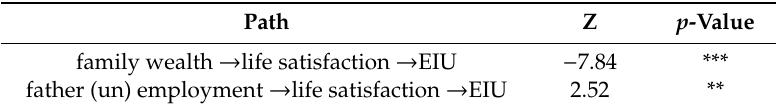
Table 4. The degree to which life satisfaction mediated the association between socioeconomic situation and excessive Internet use; results of the Sobel tests (2844 Slovak adolescents aged 13–15 years old, HBSC study 2014).